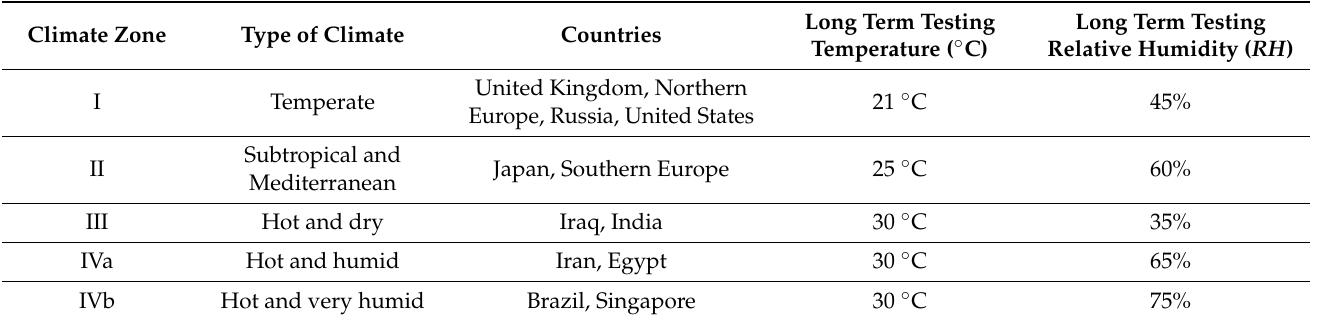
Table 2. ICH Climatic zones and long-term stability conditions [6,9,14]. The minimum time duration for long-term studies is 12 months.